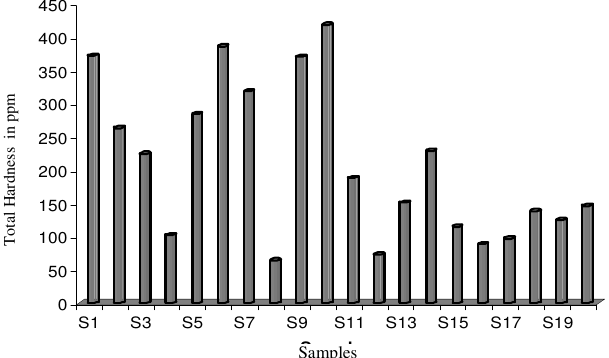
Figure 4. Total Hardness (ppm) of Water Samples Collected from Kandarvakottai (S1 to S10) and Karambakudi (S11 to S20)